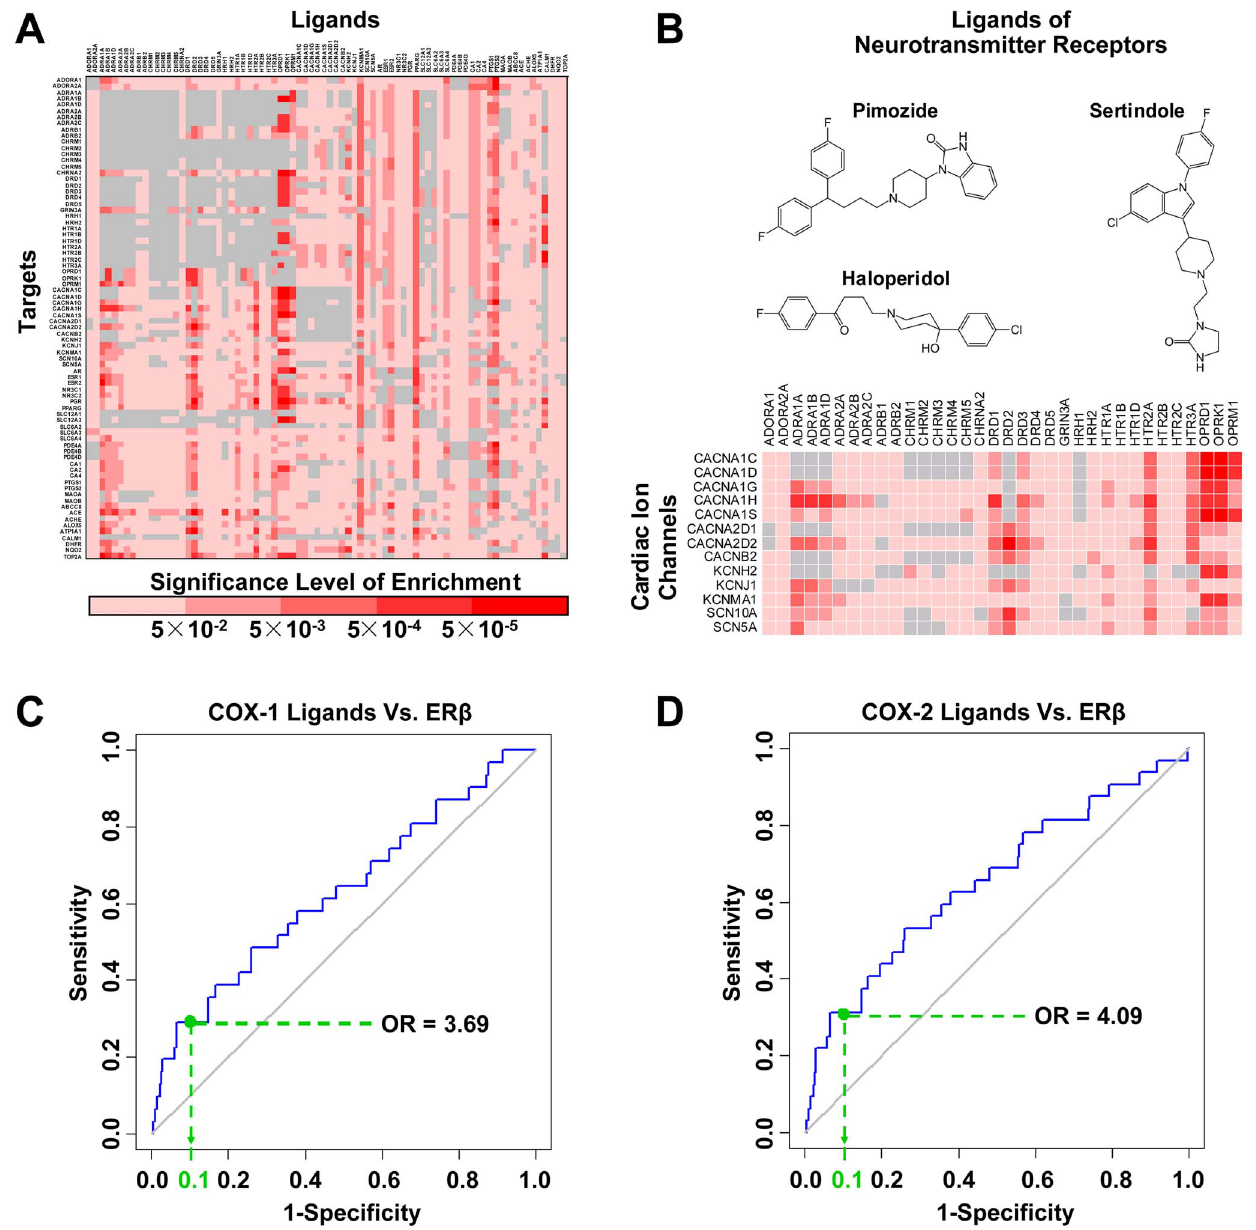
Figure 7. A summary of the highlighted potential target-target interactions. (A) The profile of target-target interaction is visualized with a matrix, in which each row and column represents a target and a family of ligands, respectively. The color of each cell represents the significance level of related target-target interaction. If a pair of targets are known to share ligands in DrugBank, their interaction (grey colored) would not be considered. (B) Potential interactions are broadly observed between antipsychotic drugs and cardiac ion channels. (C) & (D) The ligands of COX-1 (p=3.08 6 10 2 3 ) and COX-2 (p=1.02 6 10 2 3 ) generally show high LOI to estrogen receptor beta (i.e. ER b ).